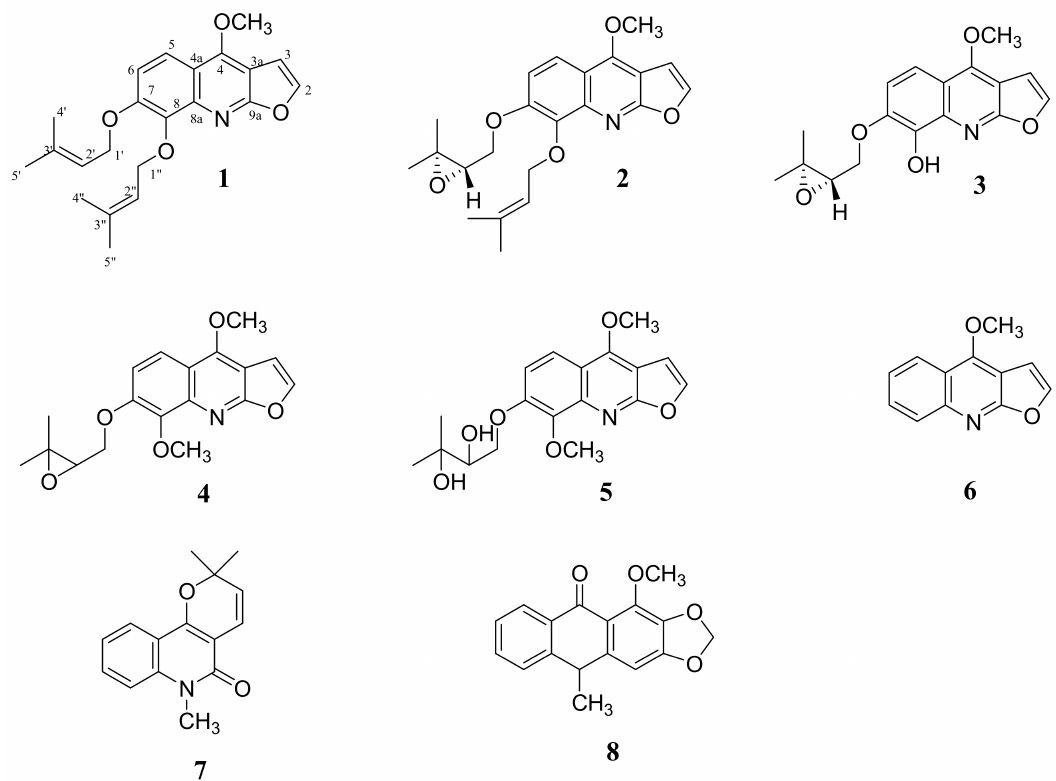
Figure 1. Structures of some isolated